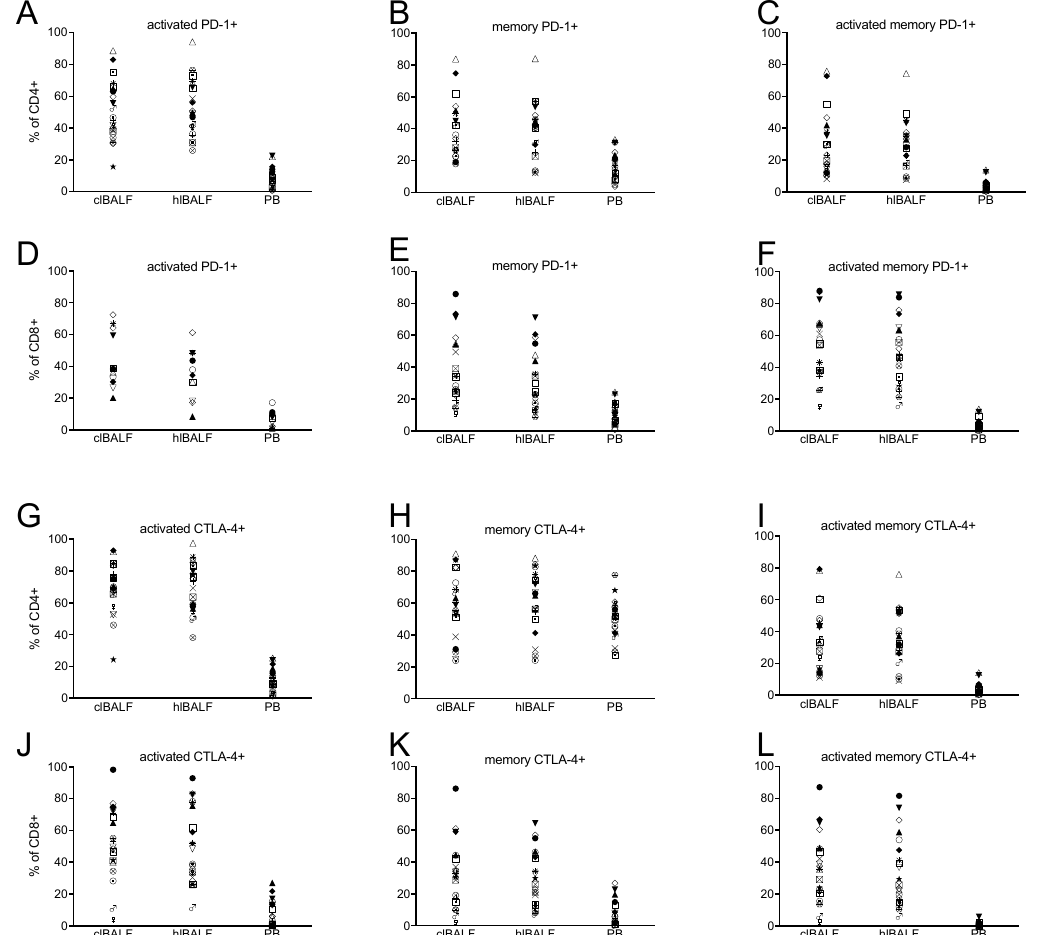
Figure 1. PD-1 and CTLA-4 expression on T cells from lung cancer patients. Data presented as individual plots of results from each patient obtained from lung cancer BAL (clBALF), the opposite ‘healthy’ lung BAL (hlBALF) and the peripheral blood (PB) Proportions of: ( A ) activated PD-1+ CD4+ T cells; ( B ) memory PD-1+ CD4+ T cells; ( C ) activated memory PD-1+ T cells; ( D ) activated PD-1 CD8+ T cells; ( E ) memory PD-1+ CD8+ T cells; ( F ) activated memory PD-1+ T cells; ( G ) activated CTLA-4+ CD4+ T cells; ( H ) memory CTLA-4+ CD4+ T cells; ( I ) activated memory CTLA-4+ T CD4+ T cells; ( J ) activated CTLA-4+ CD8+ cells; ( K ) memory CTLA-4+ CD8+ cells; ( L ) activated memory CTLA-4+ CD8+ T cells.